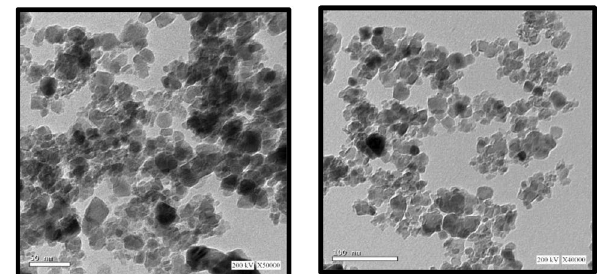
Figure 7. HRTEM of Nano CoAl 2 O 4